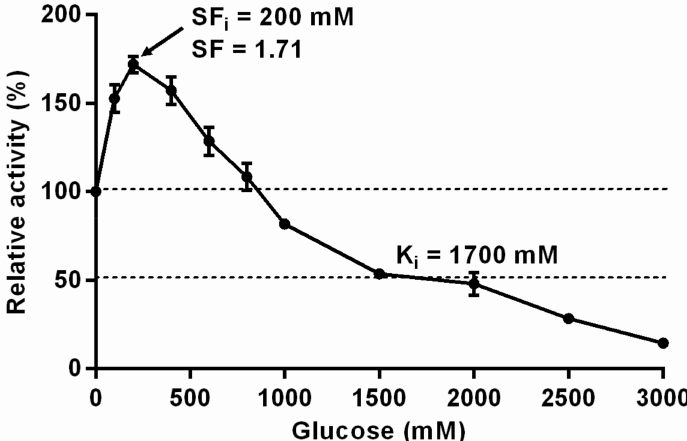
Figure 3. Glucose inhibition curve of recombinant TsBgl1. The activity assays were performed under the optimum condition of 90 ◦ C and pH 6.0 using 4 mM p NP- β -Glc as substrate in the presence of different concentrations of